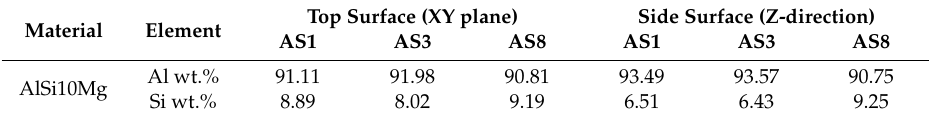
Table 4. Rietveld analysis throughout the top and side surfaces of the as-built AlSi10Mg